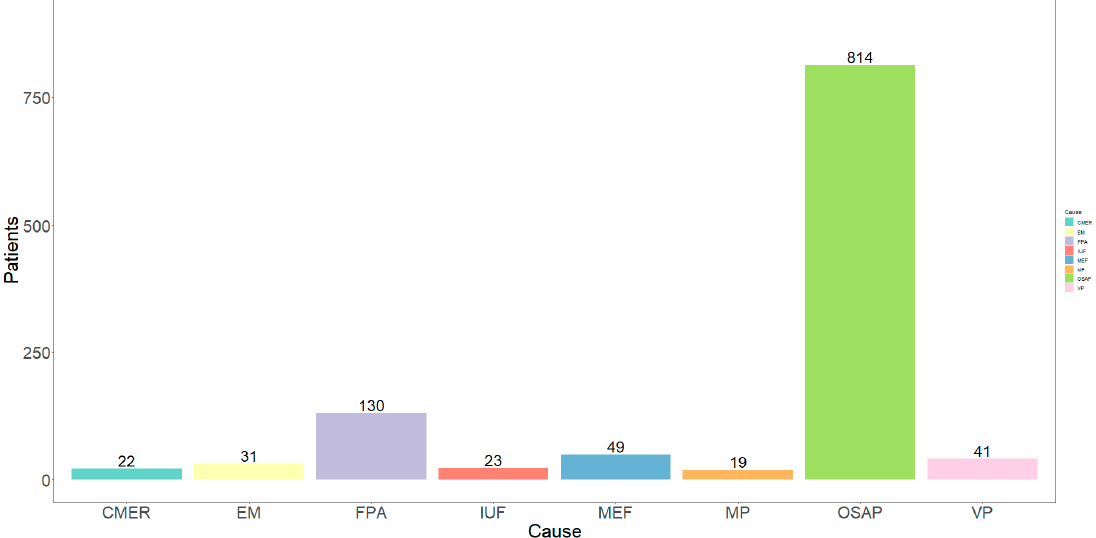
Figure 5. Distribution of causes in pediatric bone patients from 2006 to 2021. Legend : CMER (22, 1.94%) consists of BI (3 cases), CY (7 cases), PCP (5 cases), and OUR (7 cases). Birth injury (BI); excise